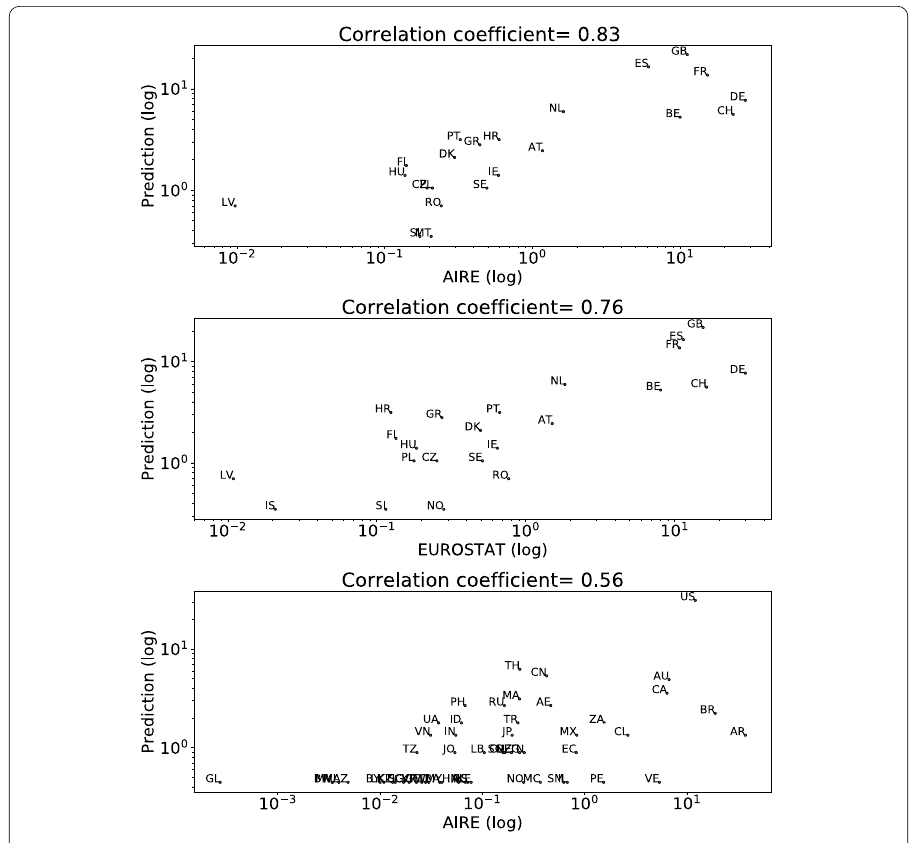
Figure 2 Percentage of Italian emigrants in various destination countries based on AIRE and Eurostat: predicted versus ground truth data. The first two figures show the results for EU countries and the last figure shows the result for non-EU